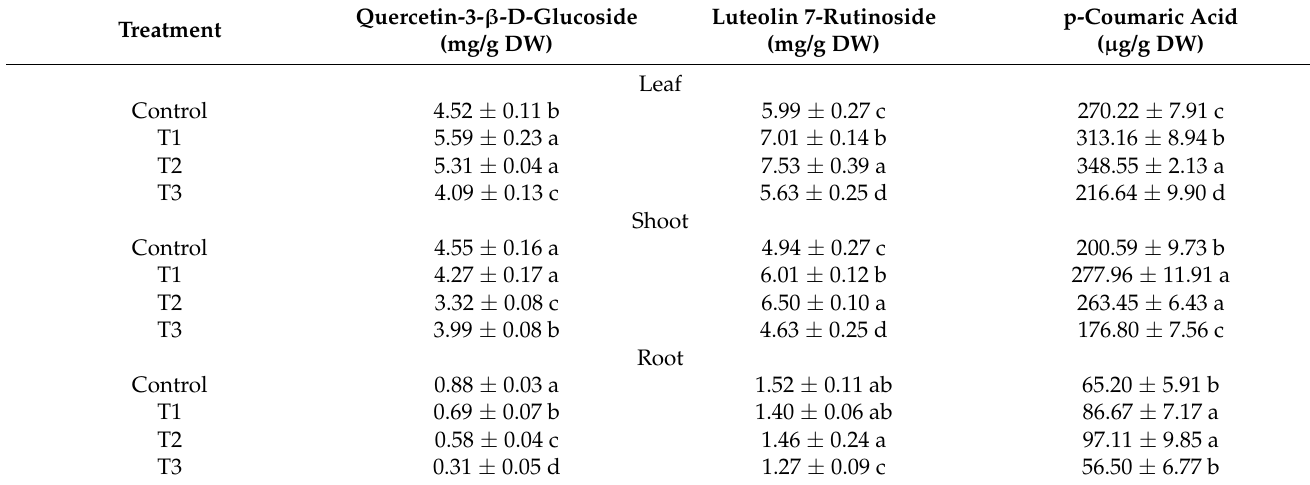
Table 2. Content of bioactive compounds in leaves, shoots and roots of E. macrochaetus .